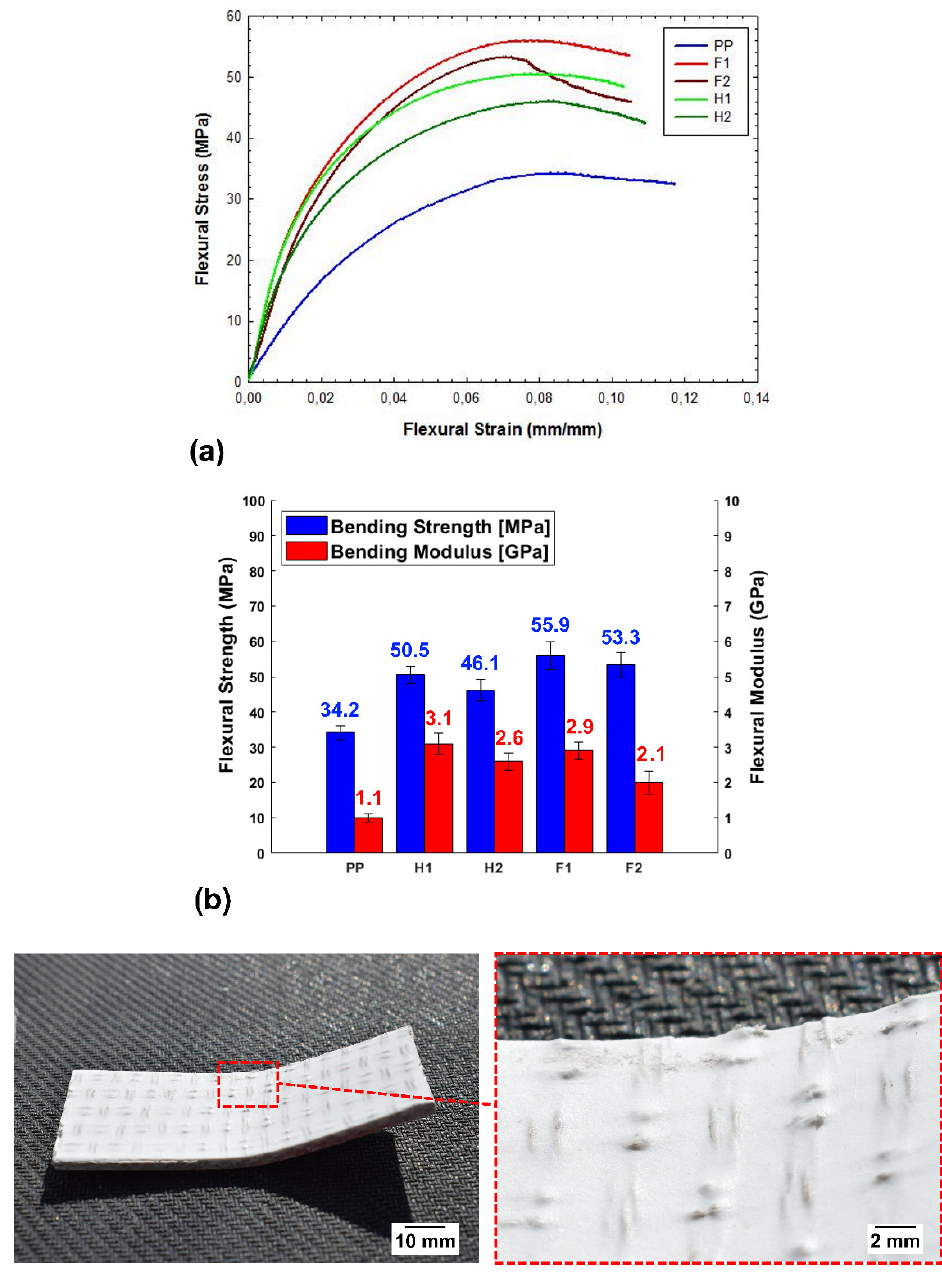
Figure 5. ( a ) Typical flexural stress-strain curves carried out from bending tests for each sample type, ( b ) their mean values of strength and modulus and ( c ) H1 sample at the end of the test.